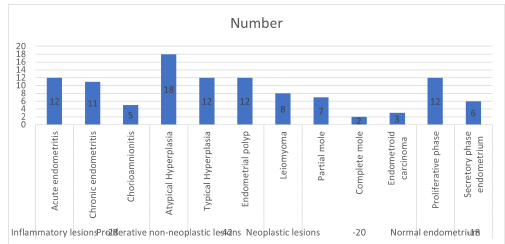
Figure 2. Histopathological diagnosis of endometrial